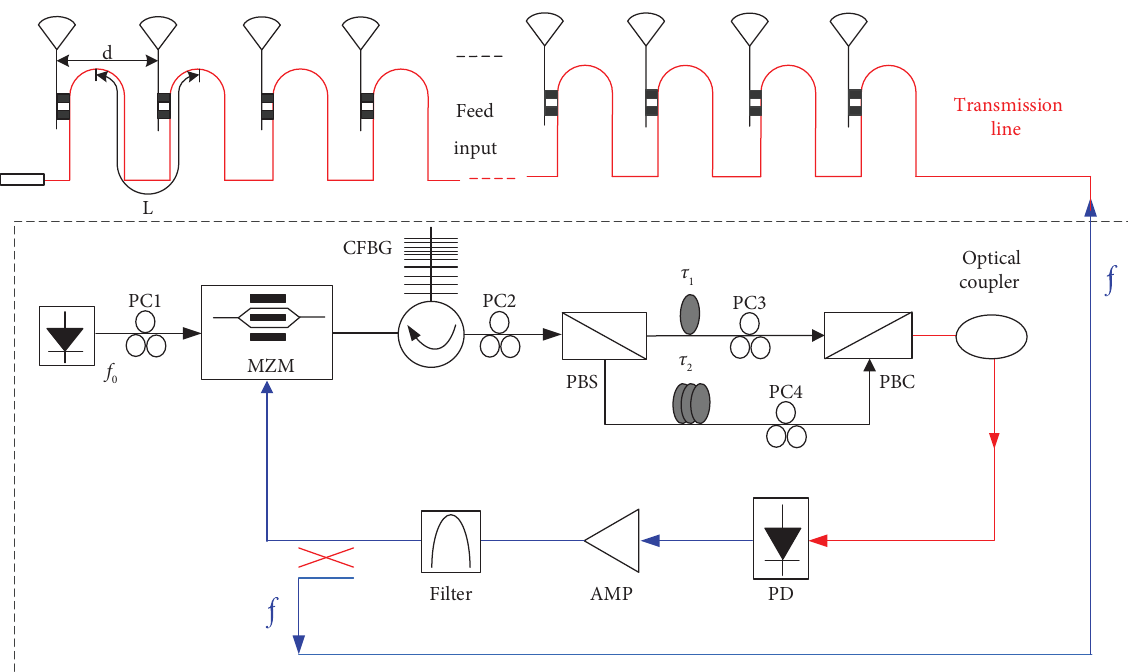
Figure 3: CFBG-based frequency scanning beamforming